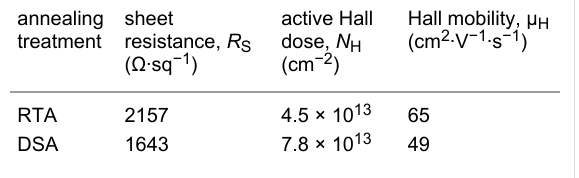
Table 1: Hall effect data measured on 11 nm thick SOI wafers implanted with As + (3 keV, 1 × 10 14 cm − 3 ) and annealed with spike- RTA or